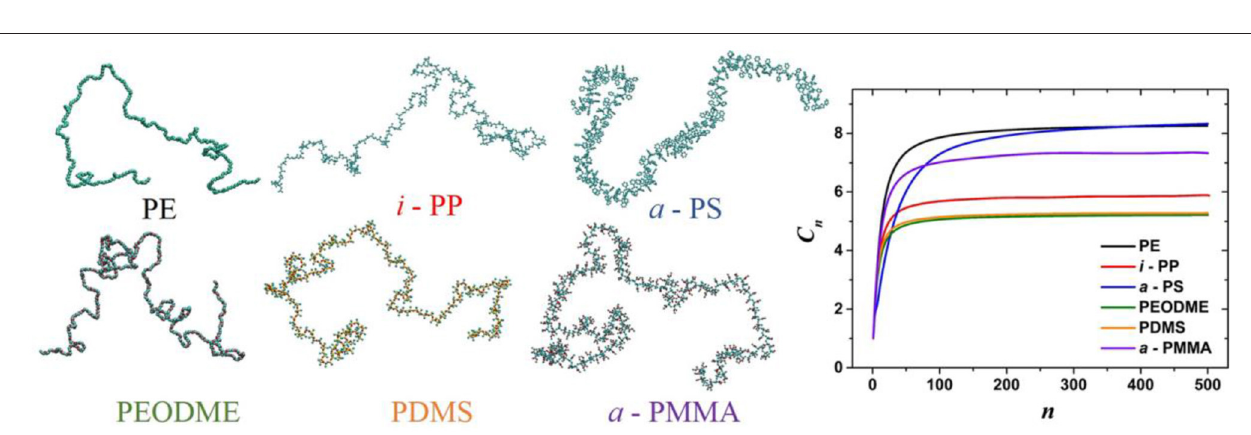
FIGURE 10 | Direct comparison between GENERIC Monte Carlo calculations and NEMD simulations for the four ( xx , xy , yy , and zz ) components of the dimensionless conformation tensor based on the chain end-to-end unit vector, ˜c ete , as a function of applied Deborah number (the dimensionless shear rate) De. Results shown are for a C 400 PE melt at T = 450K. Reproduced with permission from Roh and Baig [ 87].